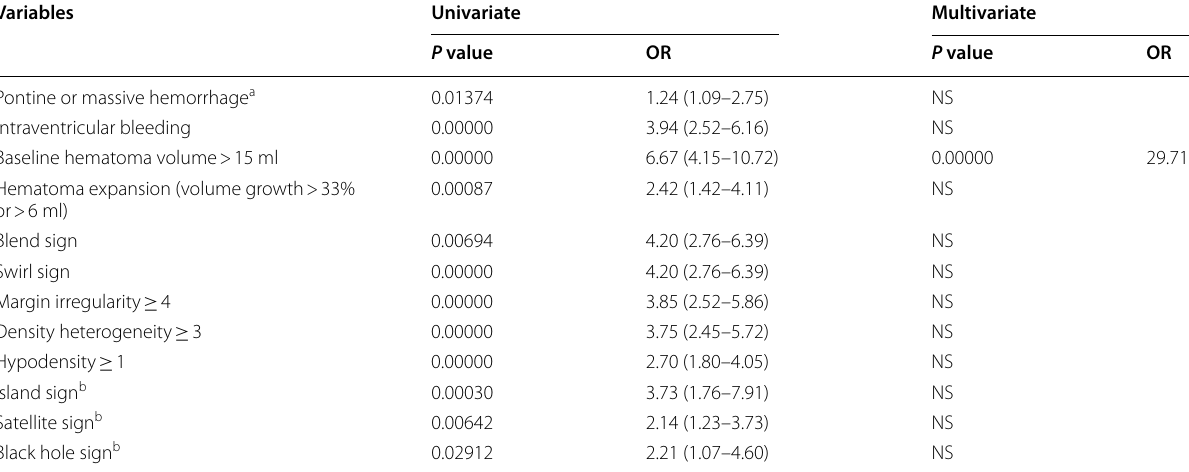
a Massive hemorrhage: lesions at least 3 cm in largest dimension in the cerebral hemispheres or 1.5 cm in the brain stem b Assessed only in the Padua cohort (n =